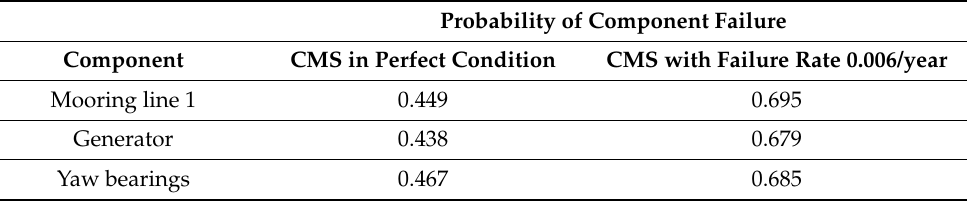
Table 5. Probability of failure of gearbox, generator and yaw bearings under with